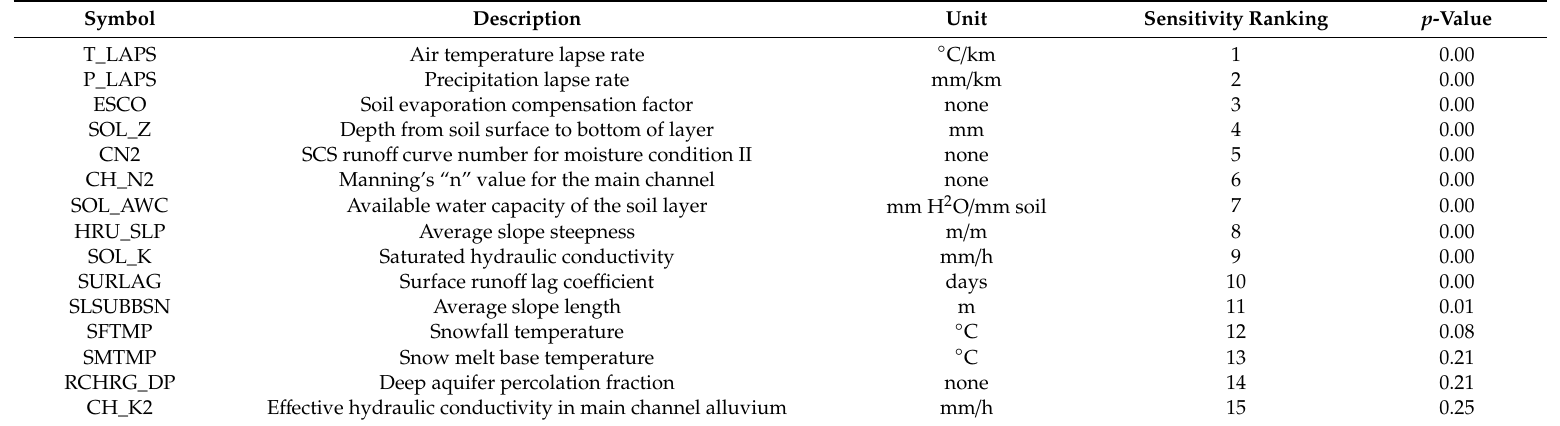
Table 3. SWAT hydrological parameters with the sensitivity ranking for stream